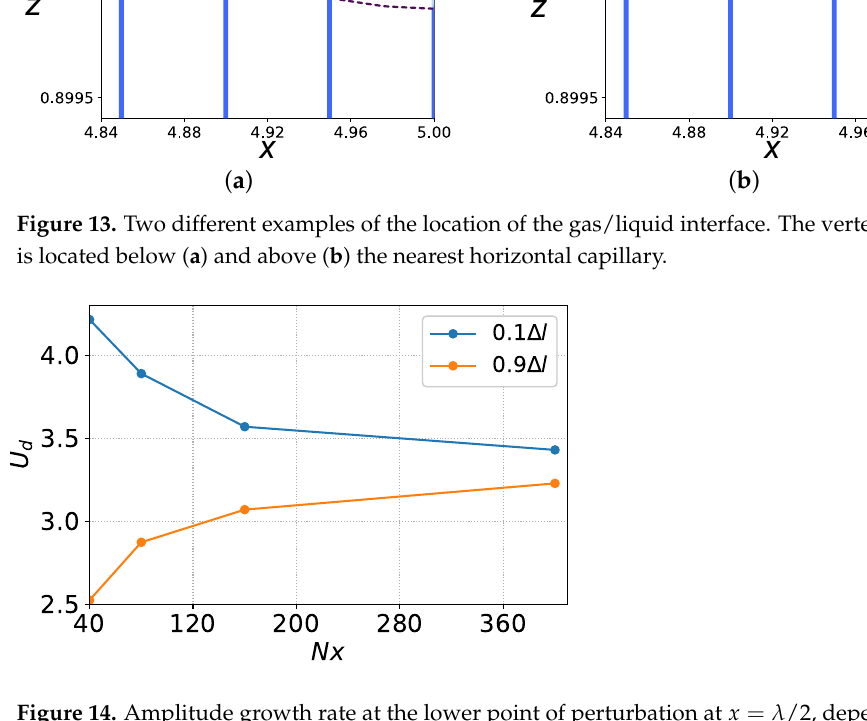
Figure 14. Amplitude growth rate at the lower point of perturbation at x = λ /2, depending on the number of vertical capillaries. The upper and lower lines correspond to the cases when the size of the part of the capillary occupied by the liquid is 0.1 ∆ l (blue line) and 0.9 ∆ l (orange line), respectively (see Figure